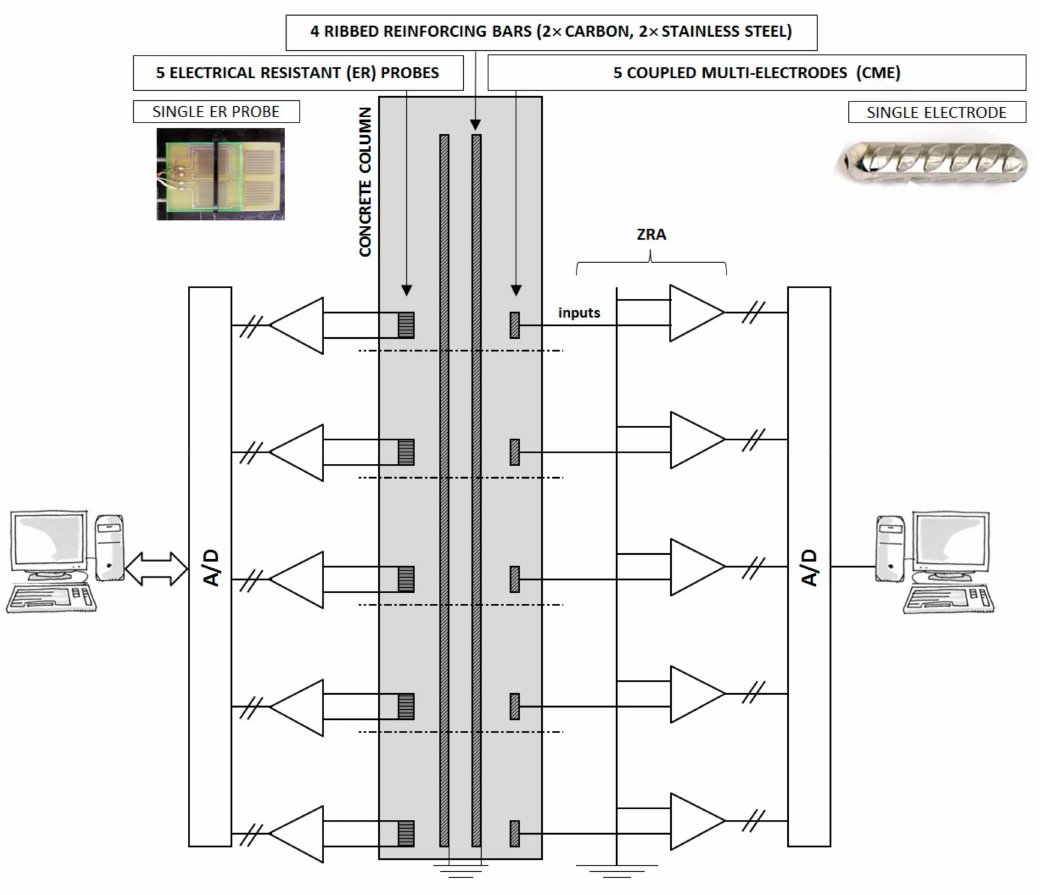
Figure 2. Schematic presentation of five individually measured electrical resistance (ER) probes and five coupled multi-electrodes connected through the Zero Resistance Ammeter (ZRA), with a photograph of a single ER probe and single